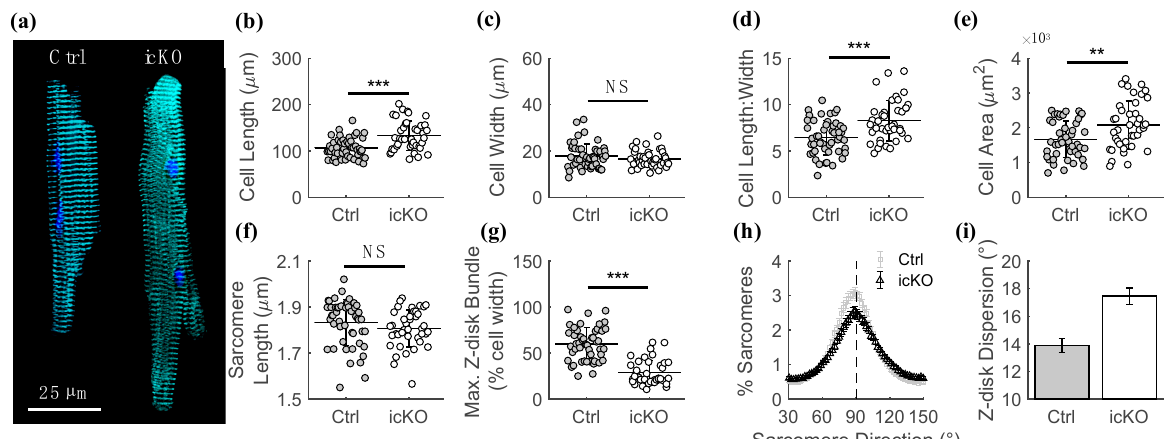
Figure 3. Adult cardiomyocytes undergo significant cellular structural remodeling in response to FLNC deletion. ( a ) Representative immunofluorescent images of control (left) and icKO (right) adult mouse ventricular cardiomyocytes, stained for the Z-disk protein α -actinin (cyan) and nuclei (DAPI, blue). The length of single cardiomyocytes ( b ) was significantly increased in cells from icKO hearts compared with controls, while the width ( c ) was not different. This leads to a significant increase in the length-to-width ratio ( d ) and surface area ( e ) of cardiomyocytes from icKO hearts compared with controls, indicative of DCM remodeling. Resting slack sarcomere length ( f ) was not different between genotypes, while maximum Z-disk transverse span (( g ); as a % of cell width) was significantly reduced in cells from icKO hearts compared with controls. Fewer sarcomeres ( h ) had Z-disks aligned perpendicularly (90°) to the long axis of the cell in cardiomyocytes from icKO hearts (black) compared with control (gray), causing the angular dispersion of Z-disk orientation ( i ) to be greater in cardiomyocytes from icKO hearts compared with controls. ** p < 0.005, *** p < 0.0005, and NS = Not Significant for unpaired Student’s t -test.